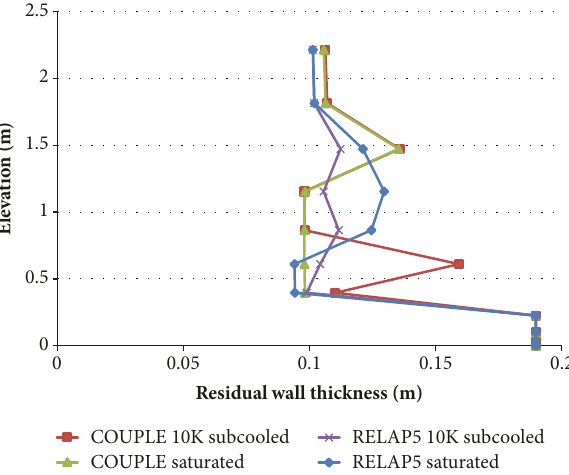
Figure 16: Residual wall thickness of the RPV for each